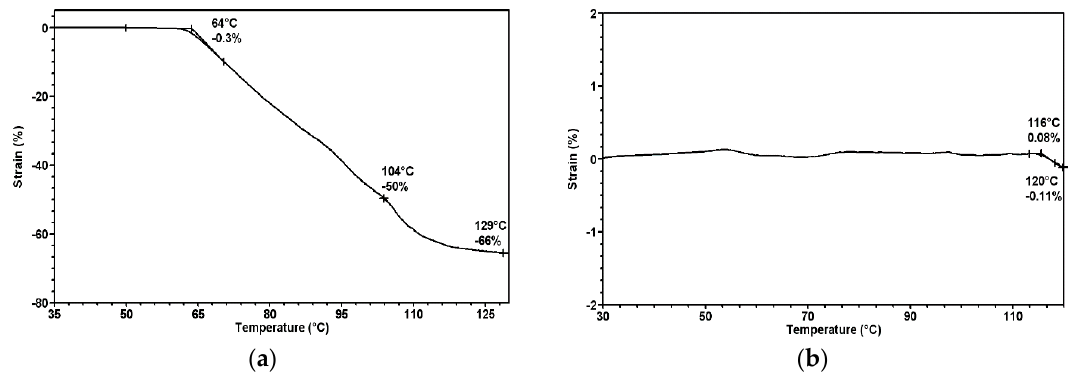
Figure 2. Strain versus temperature dependence measured in a dynamic thermo-mechanical analysis of ( a )—nonwoven fabric before the thermal stabilization process; ( b )—nonwoven fabric after the thermal stabilization process.